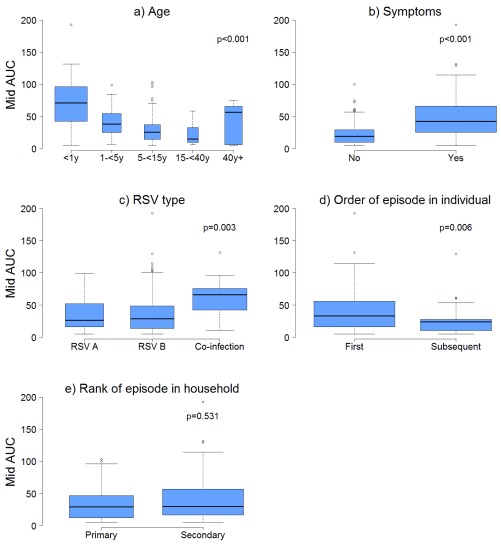
Box and whisker plots showing the distribution of amount of virus shed (AUC) using the midpoint estimates by
a) age
b) symptoms
c) RSV type
d) order of episode in individual, and
e) primary or secondary episode in household. The width of a box relative to other boxes in the same plot is directly proportional to the mean duration of shedding in each category of that plot.